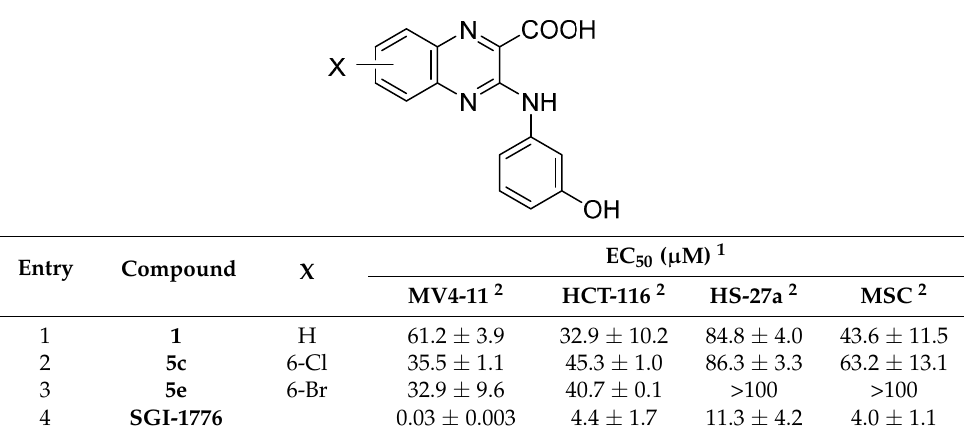
Table 3. Cell ‐ based assays of the most active Table 3. Cell-based assays of the most active quinoxalines.